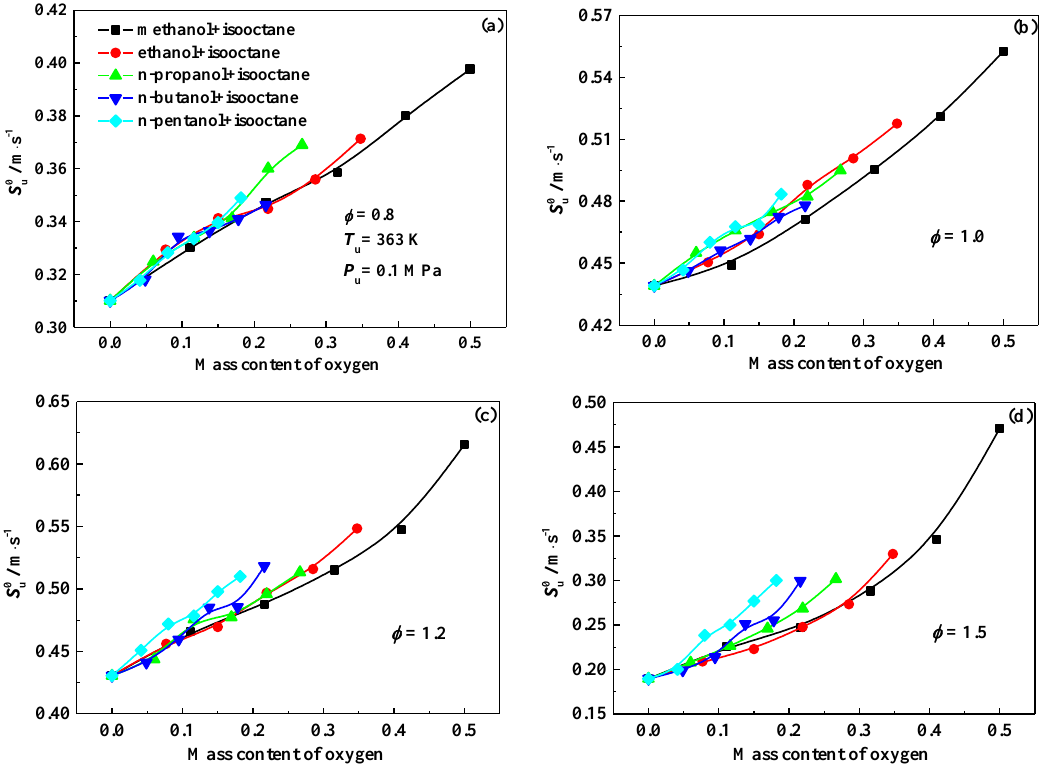
Figure 10. Laminar flame speeds of alcohol-isooctane blends vs. mass content of oxygen at 363 K, 0.1 MPa, and different equivalence ratios: ( a ) ϕ = 0.8; ( b ) ϕ = 1.0; ( c ) ϕ = 1.2; and ( d ) ϕ = 1.5.